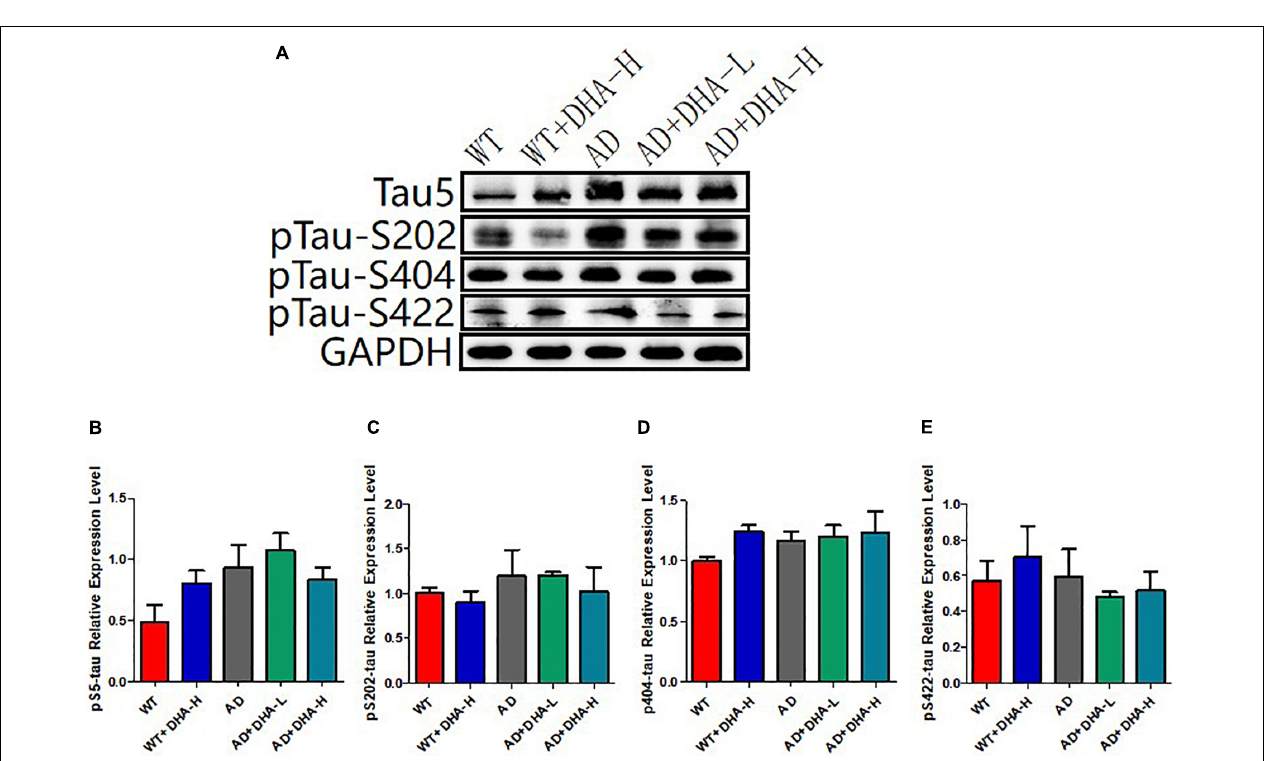
FIGURE 4 | Effect of DHA treatment on deposition of A β in the hippocampus and cortex of 2 × Tg AD mice. CA3:CA3 area of mouse hippocampus; CA1, CA1 area of mouse hippocampus; Cor, cortical area; DG, dentate gyrus area of hippocampus ( n = 4).